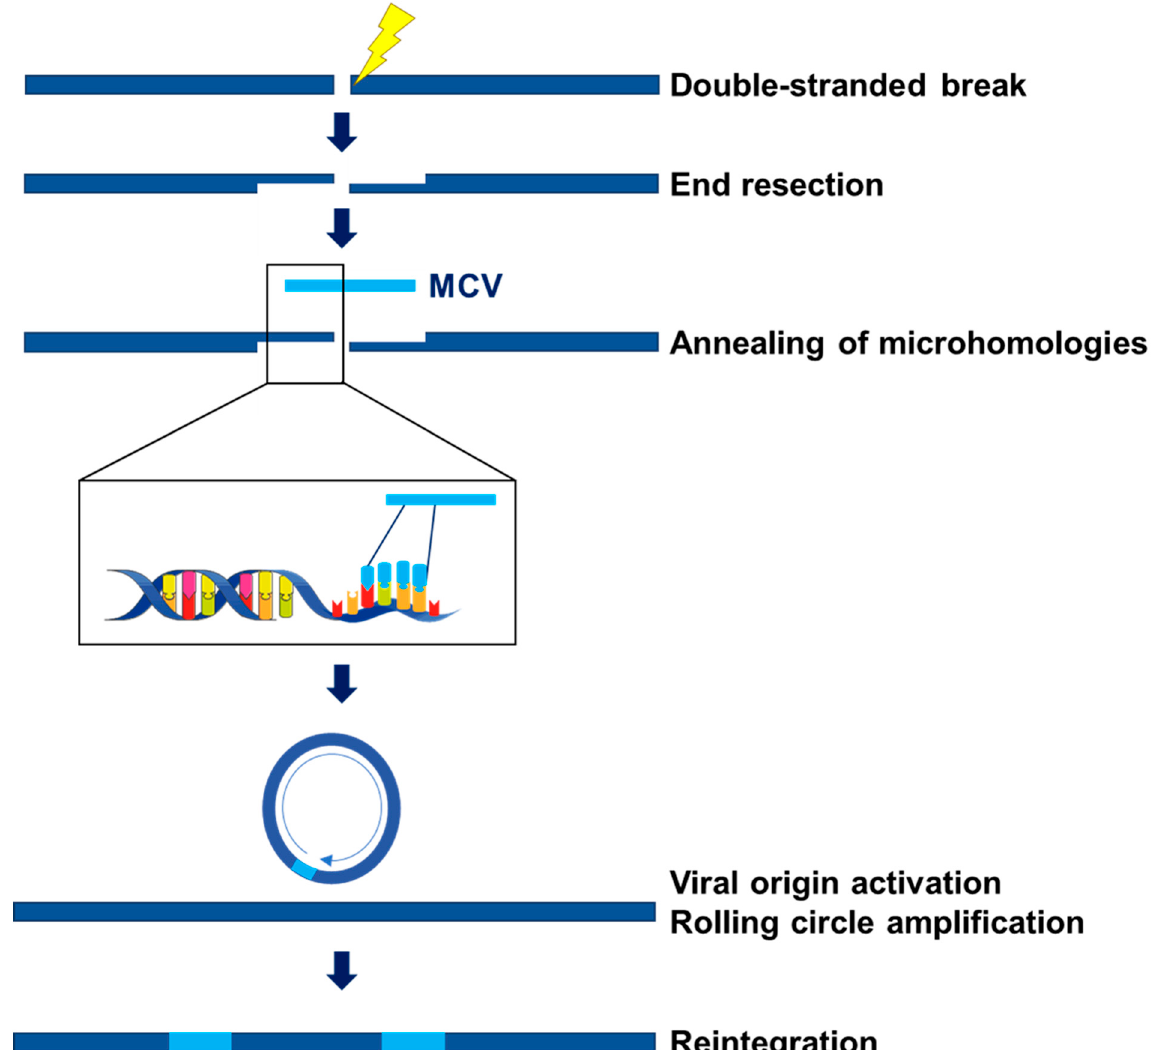
Figure 2. Proposed model of MCV integration as described by Starrett et al. [15,28]. A double-stranded break in the host genome activates the DNA damage response. The DSB ends of the host DNA undergo end resection, creating single-stranded DNA overhangs. A linearized MCV genome anneals to resected host DNA at microhomologous sequences. The viral origin of replication is activated, leading to rolling circle amplification of viral DNA and the surrounding host DNA. DNA repair mechanisms facilitate the resolution and reintegration of the circular virus–host intermediate, resulting in linear cellular DNA flanked by viral DNA. Part of this image was modified from smart.servier.com, accessed on 1 November 2021.